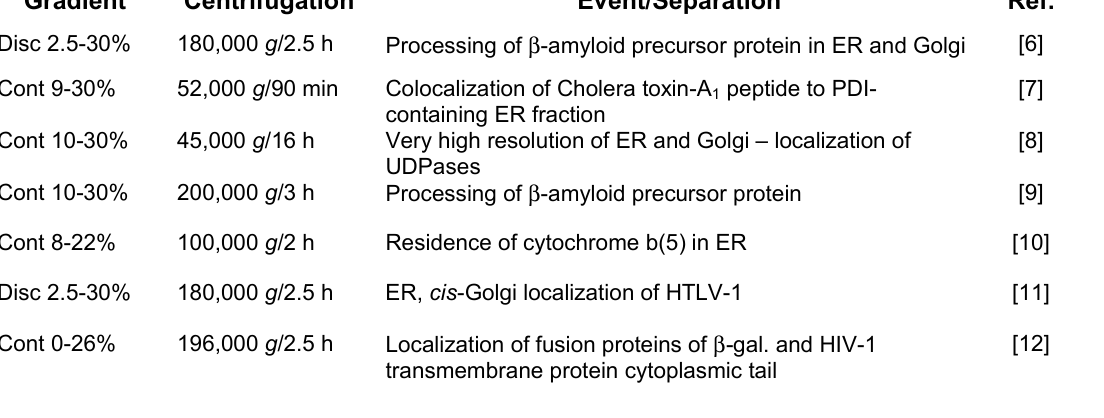
Separation of ER, Golgi, and PM using Preformed Iodixanol Gradient (Selected Publications) Gradient Centrifugation Event/Separation